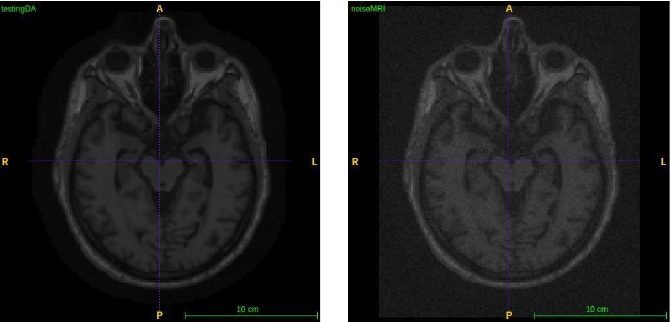
Figure 3. The original MRI processing method. Pictures from top to bottom are MRI after removing the skull, flip, and rotation; image registration; the White Matter (WM) extraction MRI extraction.